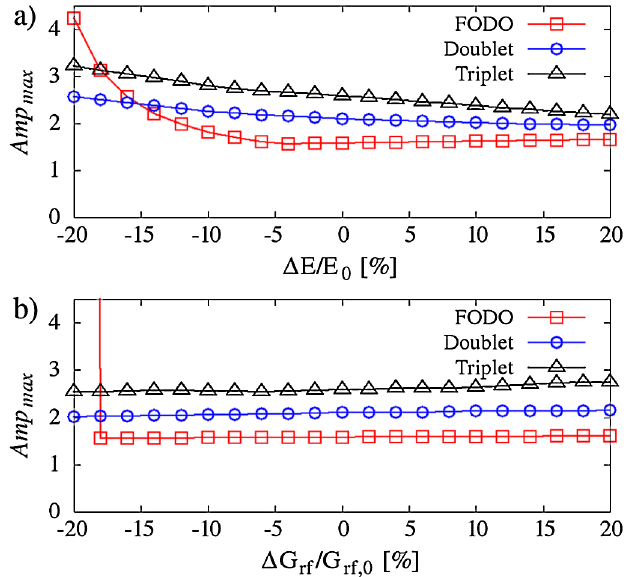
FIG. 9. Amplification of the beam in DBL1, (a) for different initial beam energy and (b) for different accelerating gradient.